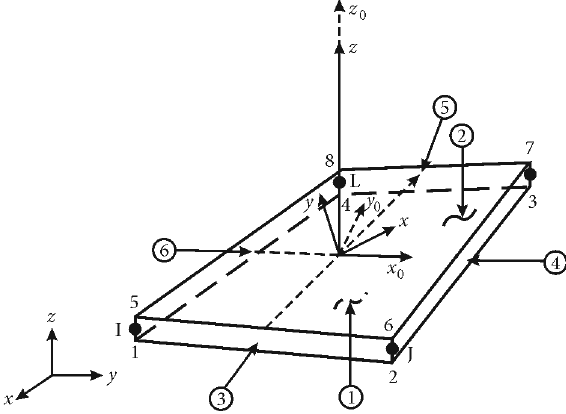
Fig. 3. Degrees of freedom of element Shell 181